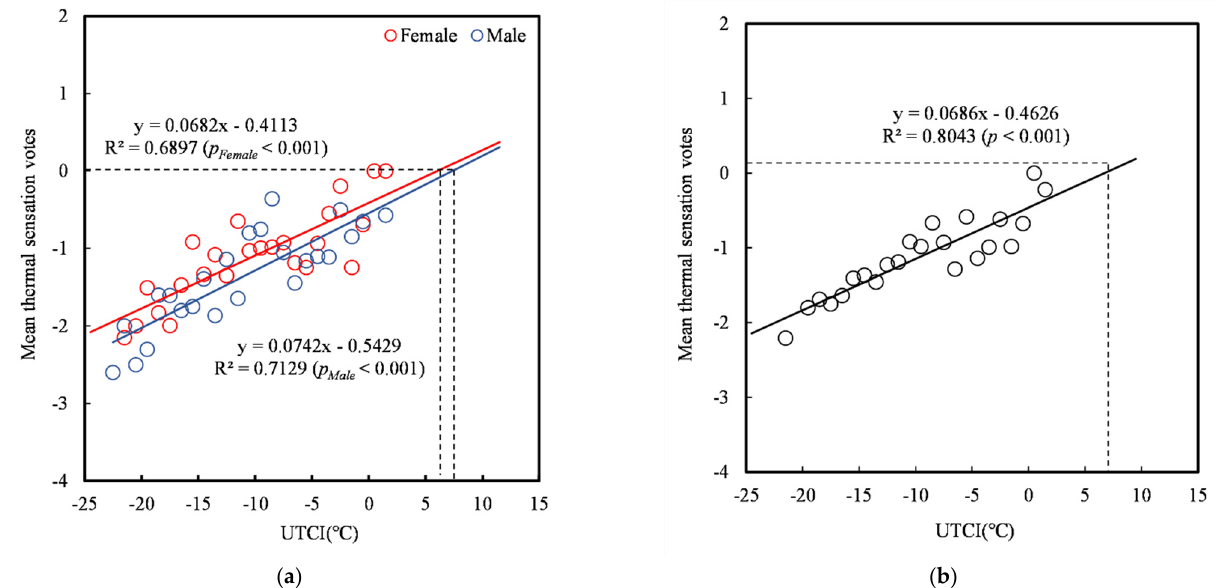
Figure 8. UTCI vs. mean TSV: ( a ) female and male children and ( b ) all.